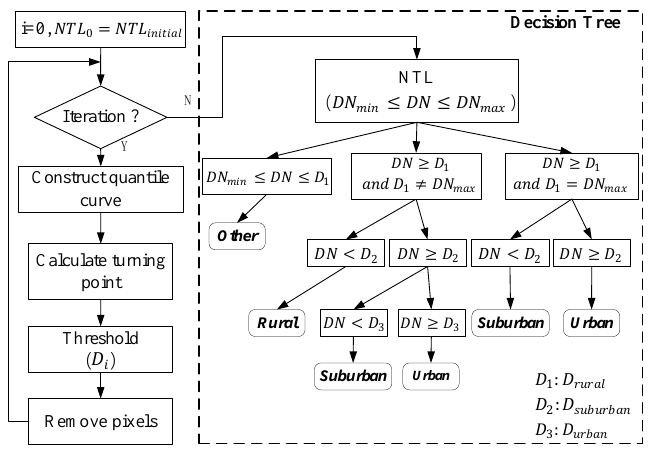
Figure 5. USR NTL threshold determination.